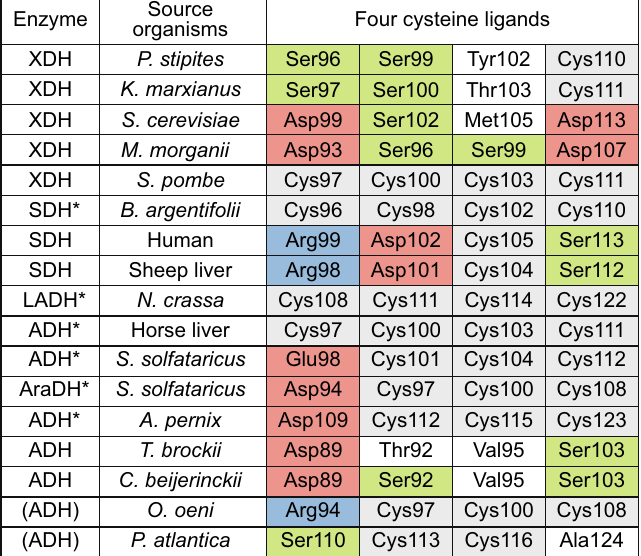
Figure 2. Four cysteine ligands for structural zinc binding in MDR enzymes. Cysteine, serine, acidic, and basic residues are shadowed in gray, yellow-green, red, and blue, respectively. Proteins with asterisks possess structural zinc based on a crystallographic